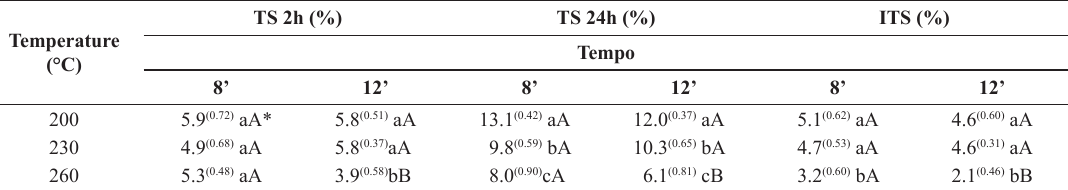
Table 7. Unfolding of interactions for the physical properties TS and